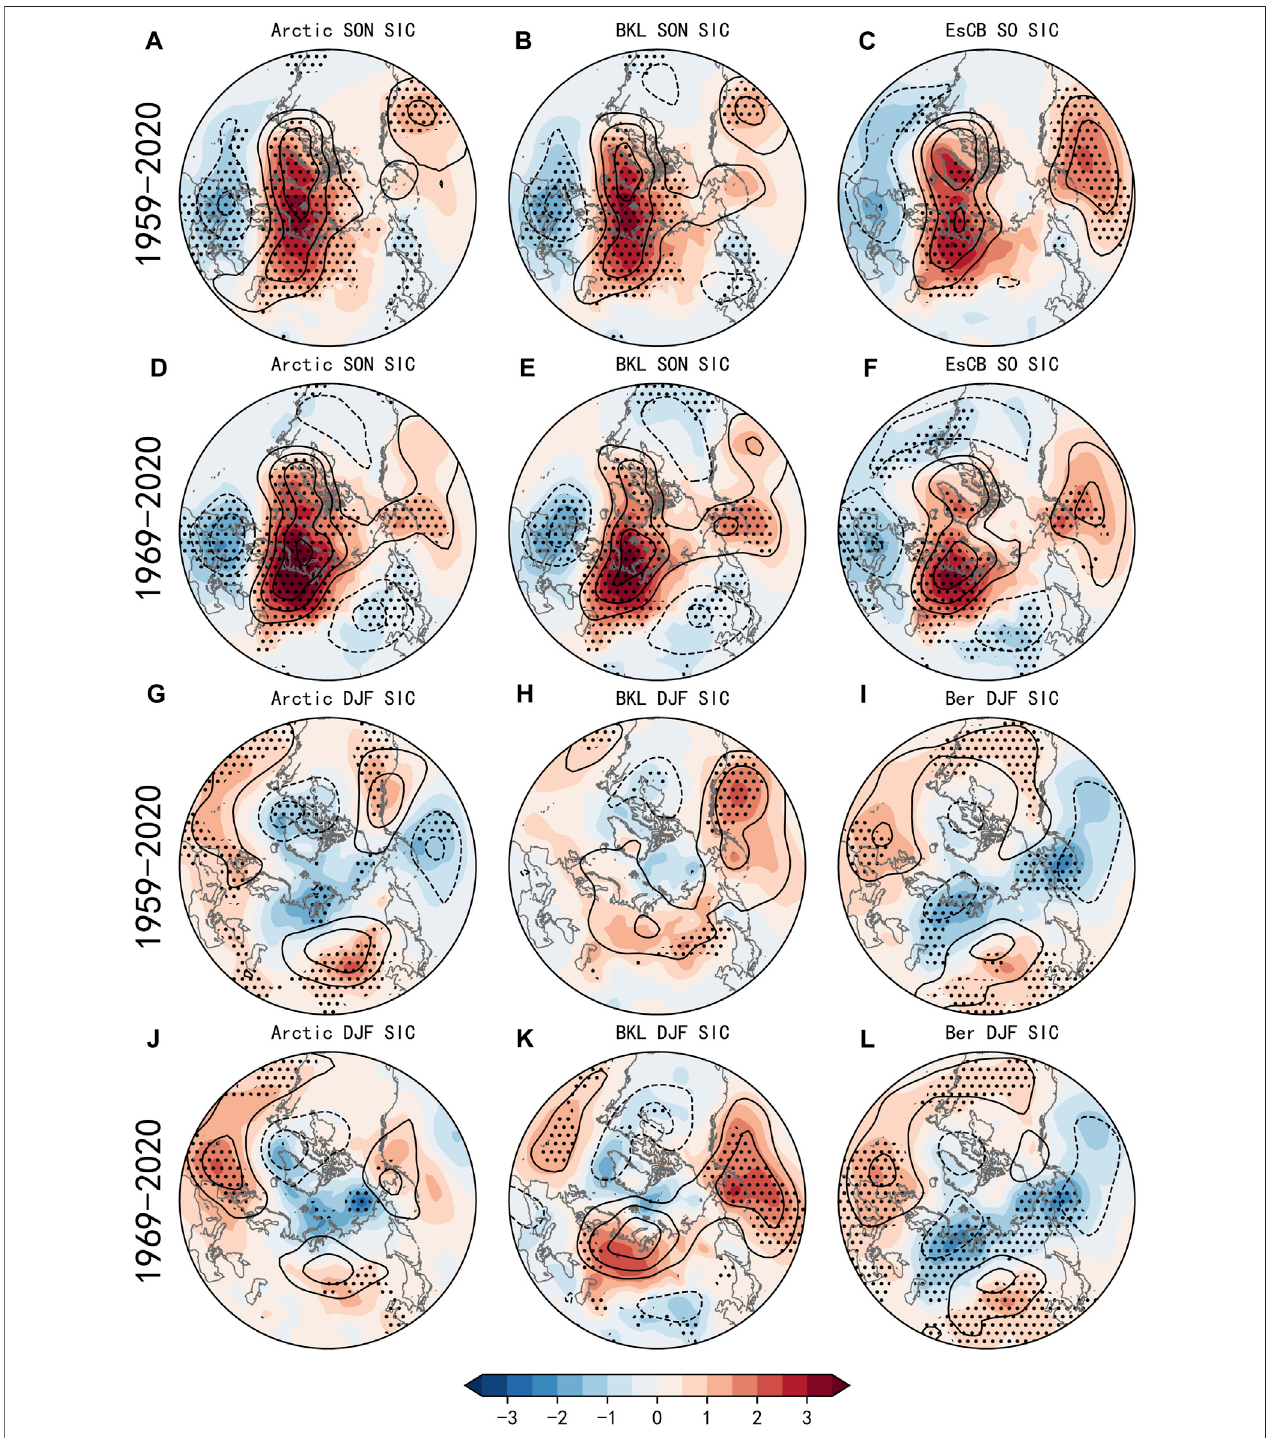
FIGURE 12 | As in Figure 4 but for interdecadal sea-ice loss during 1959 – 2020 [ (A – C) and (G – L) ] and 1969 – 2020 [( D – F) and (J – L) ].